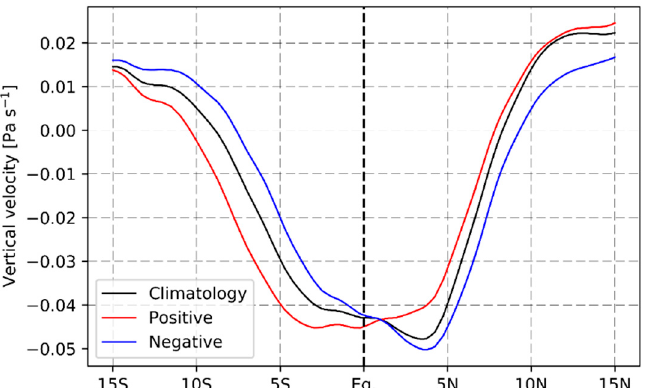
Figure 7. Vertical velocity ( ω ), the values are zonally averaged in the 80° W–15° W domain. The black line is the MAM climatology. The red and the blue lines are the MAM average for the 10 years with maximum and minimum PC3 amplitude, respectively. Data from ECMWF ERA-20C reanaly- sis.